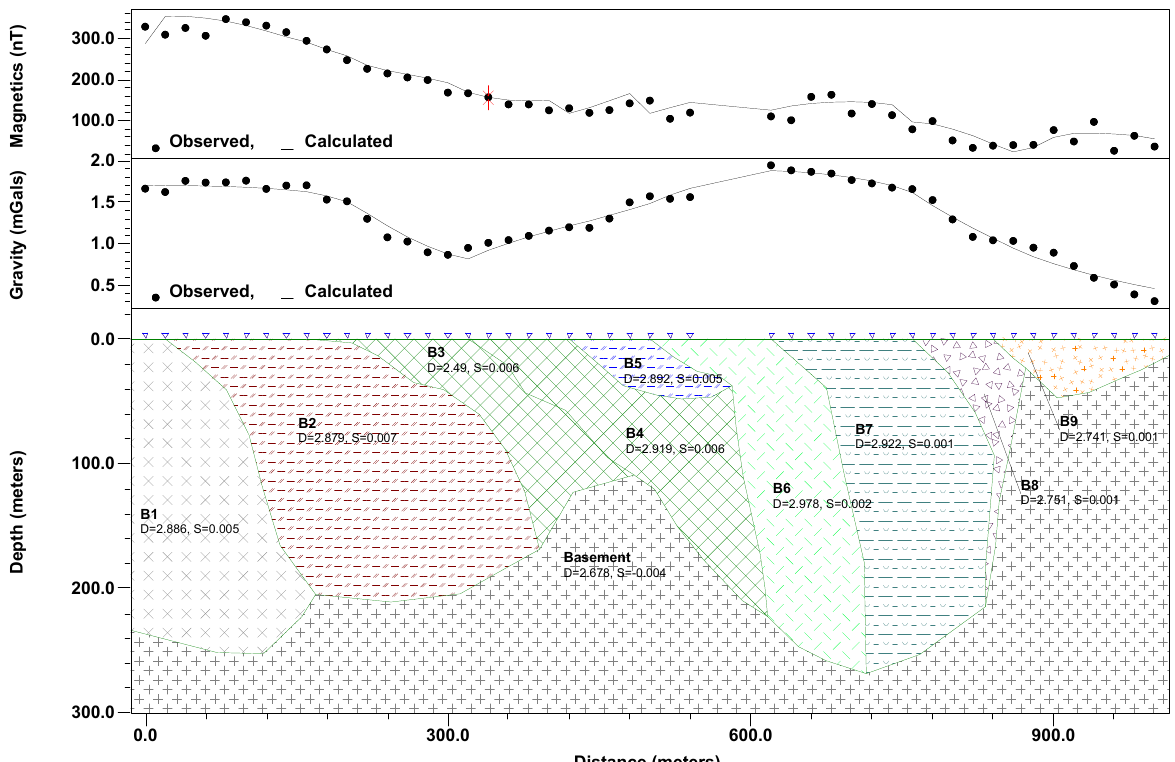
Figure 9. Joint magnetic and gravity modeling of Line 3. Numbers on the polygons represent, respectively, the magnetic susceptibility in CGS and the density contrast in g/cm 3 . Distance 0 corresponds to station 600m and distance 1000 corresponds to station